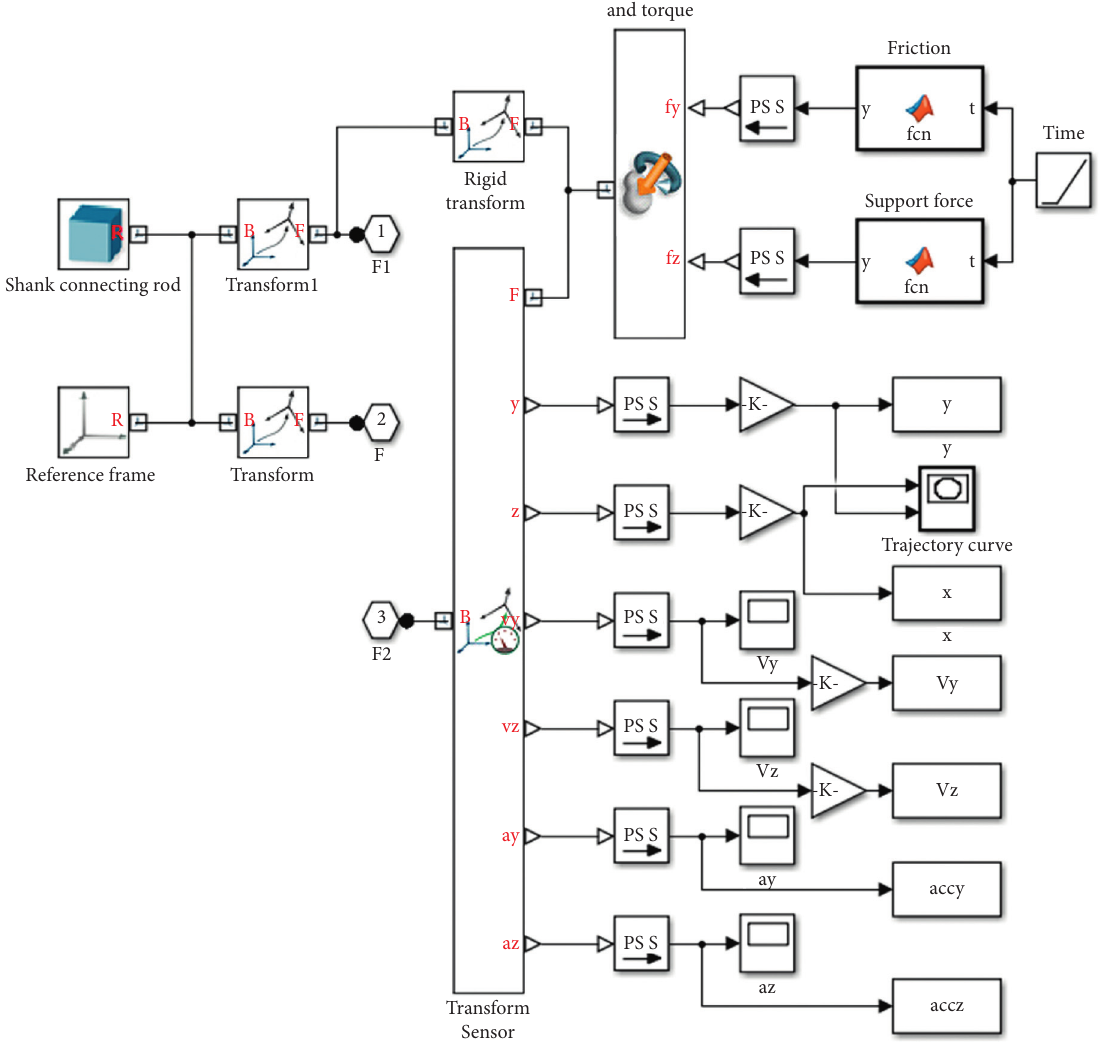
Figure 9: Display system of foot track.